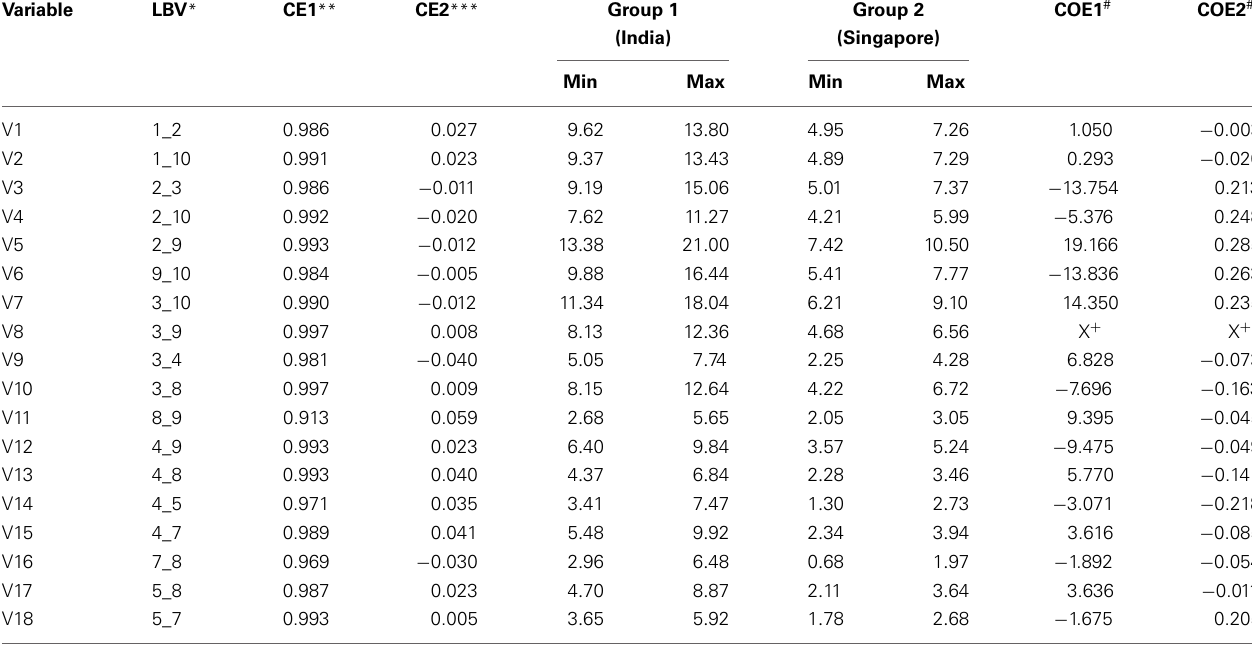
Table 3 | Truss morphometric analyses to study differences at the morphological level between the two identified species. Variable